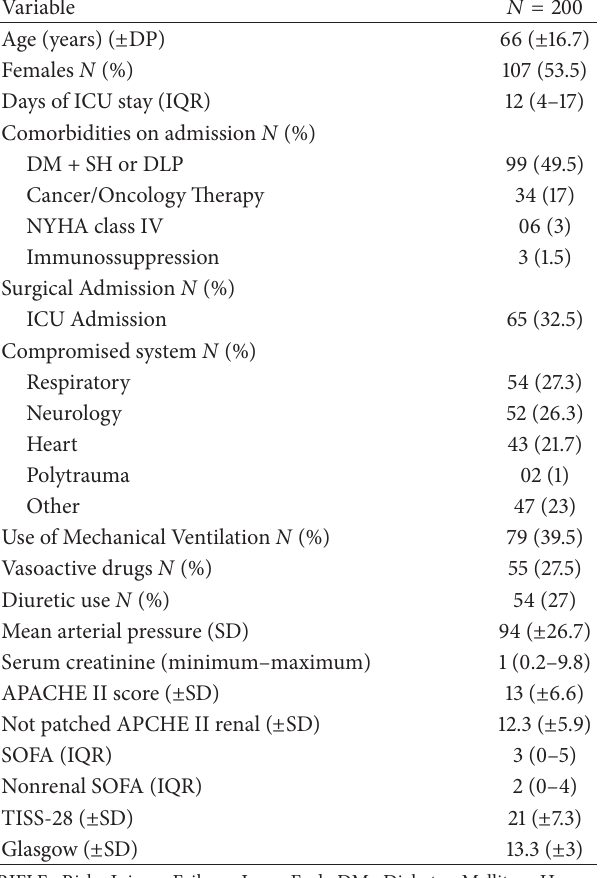
Table 2: Demographic and clinical characteristics of critically ill patients defined by the RIFLE classification.